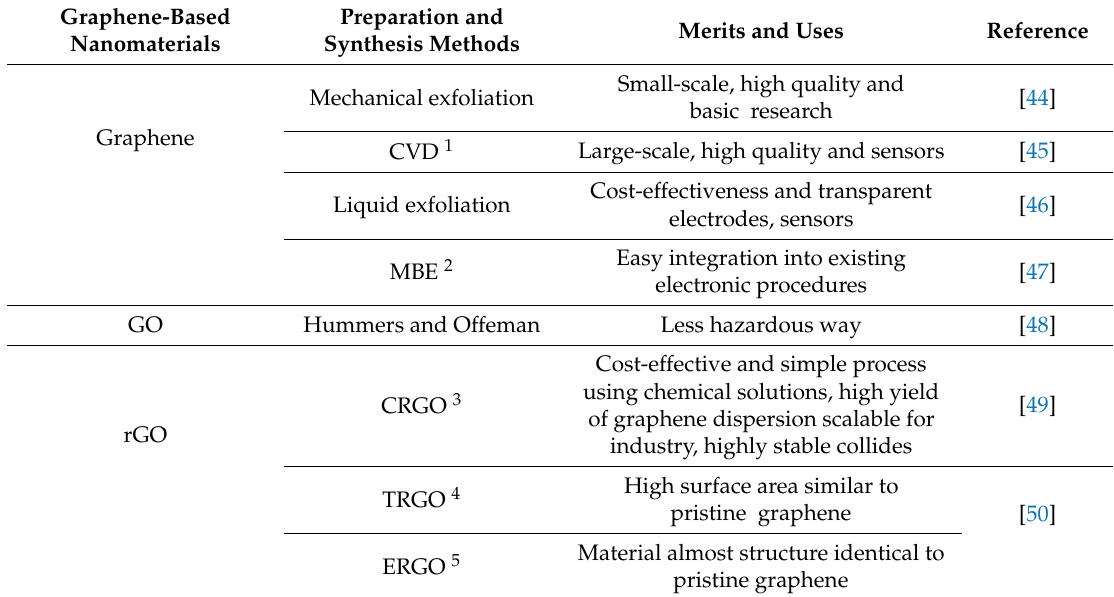
Figure 3. Structures of graphene nanomaterials: ( a ) Graphene with sp 2 -hybridized carbon atoms; ( b ) Chemically modified graphene including graphene oxide (GO); ( c ) reduced graphene oxide (rGO) (reprinted with permission from [41]). Table 1. Representative reparation and synthesis methods for graphene